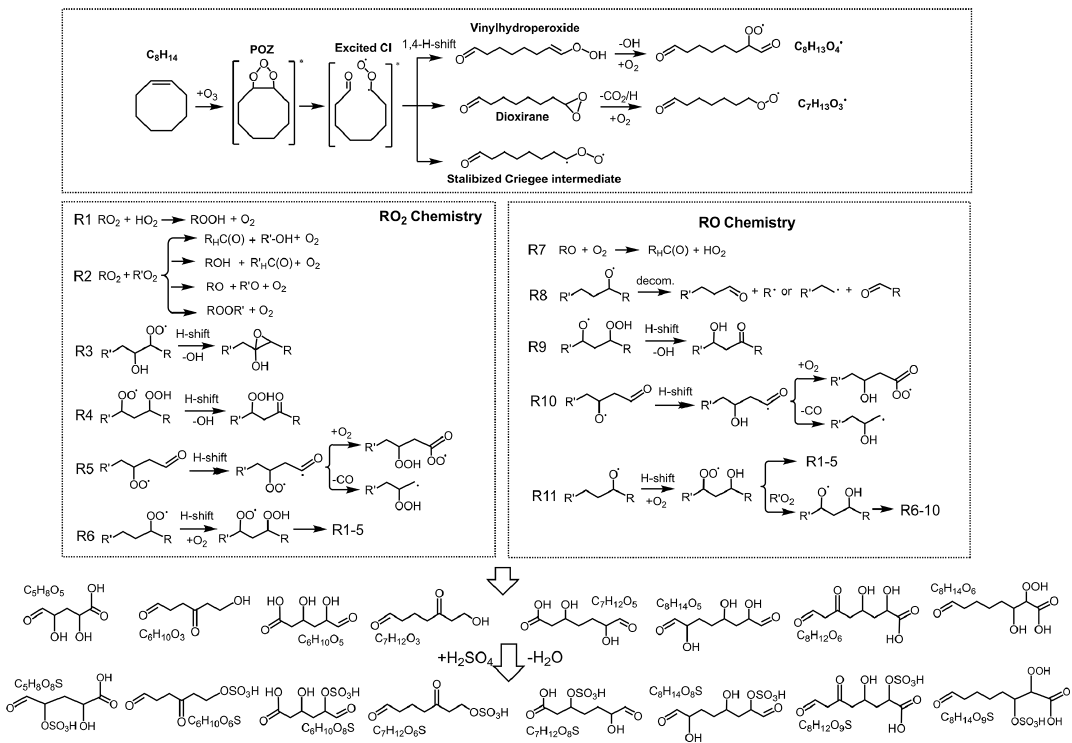
Figure 6. Simplified formation schemes for the selected organosulfates formed from the ozonolysis of cyclooctene.